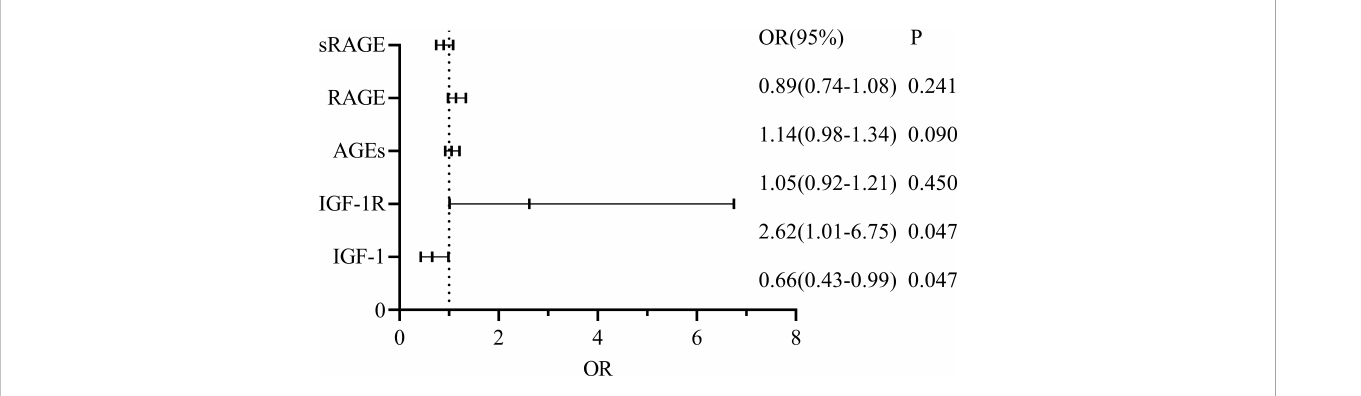
FIGURE 5 Logistic regression analysis for the CRC+T2DM